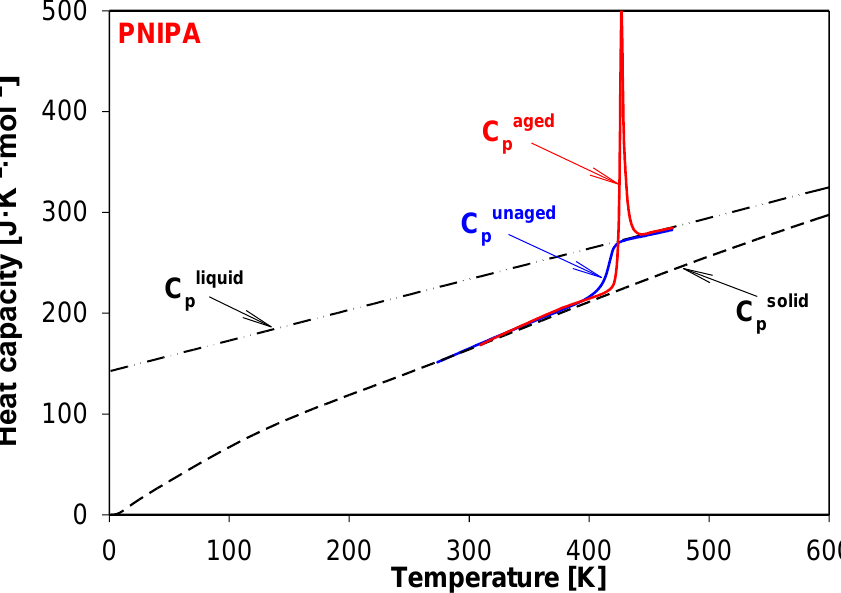
Figure 9. Experimental apparent heat capacities of aged and unaged PNIPA versus temperature were compared with equilibrium solid (C psolid ) and liquid (C pliquid ) heat capacities. The result of physical aging process was obtained based on the storage of material at 400.15 K for 1 year.